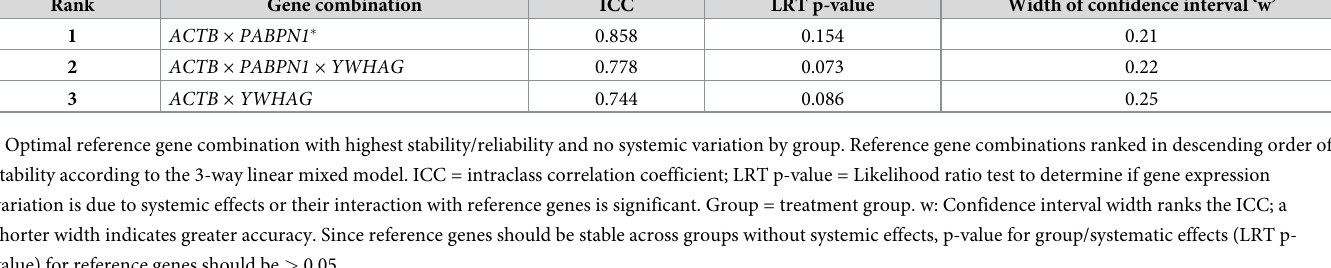
Table 6. Top 3 most stable reference genes combinations using 3-way LMM.